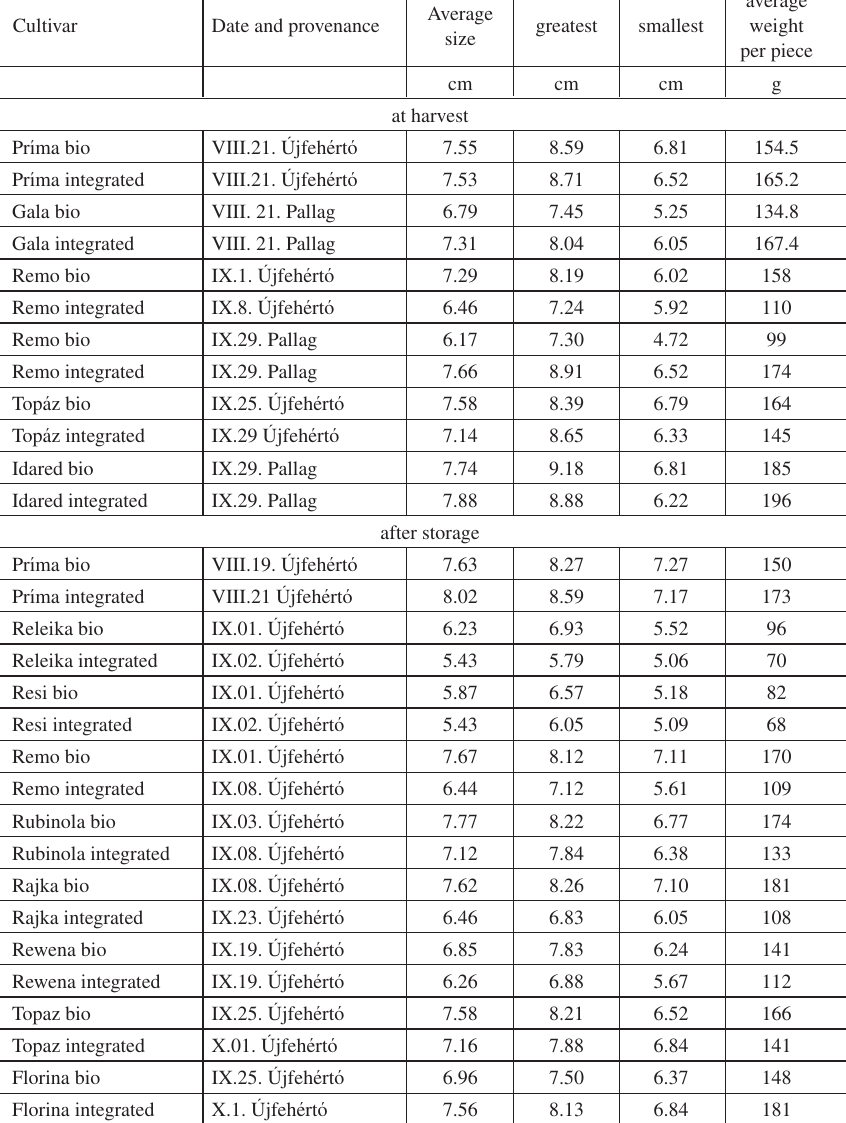
Table 2. Size and weight of apples at harvest and after